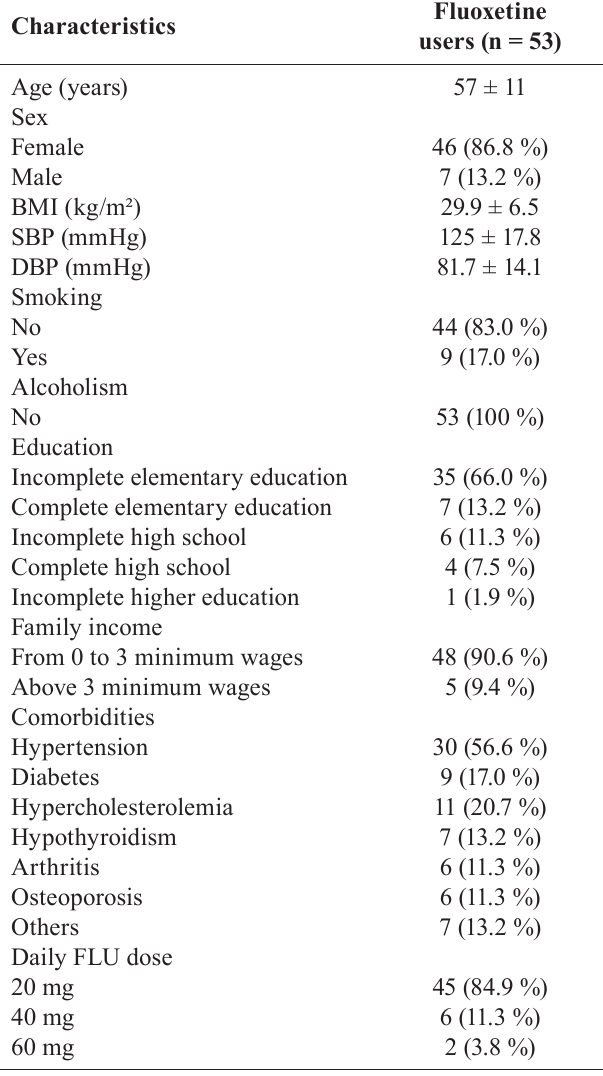
TABLE I - C linical and social demographic characteristics of fluoxetine